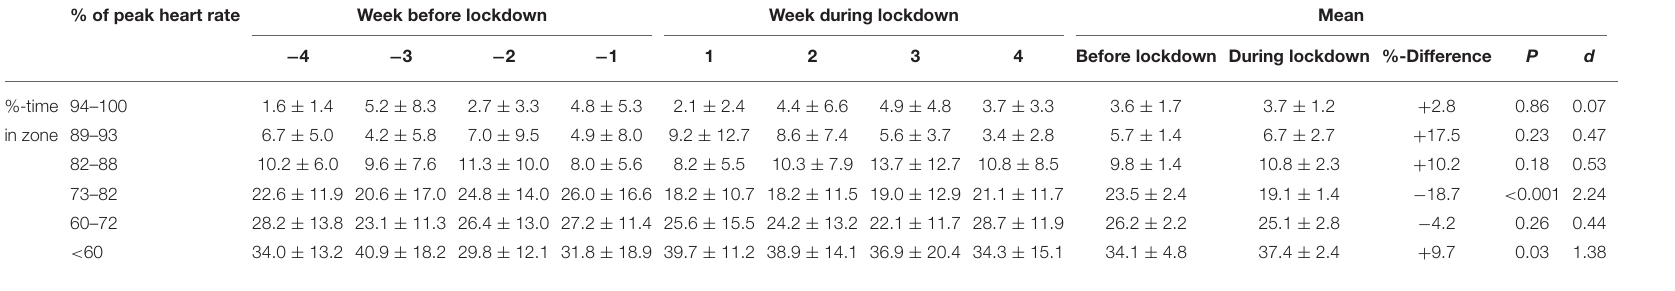
TABLE 3 | The mean percentage of the total training time each week spent in each intensity zone during the 4-weeks periods prior to and at the beginning of the lockdown. % of peak heart